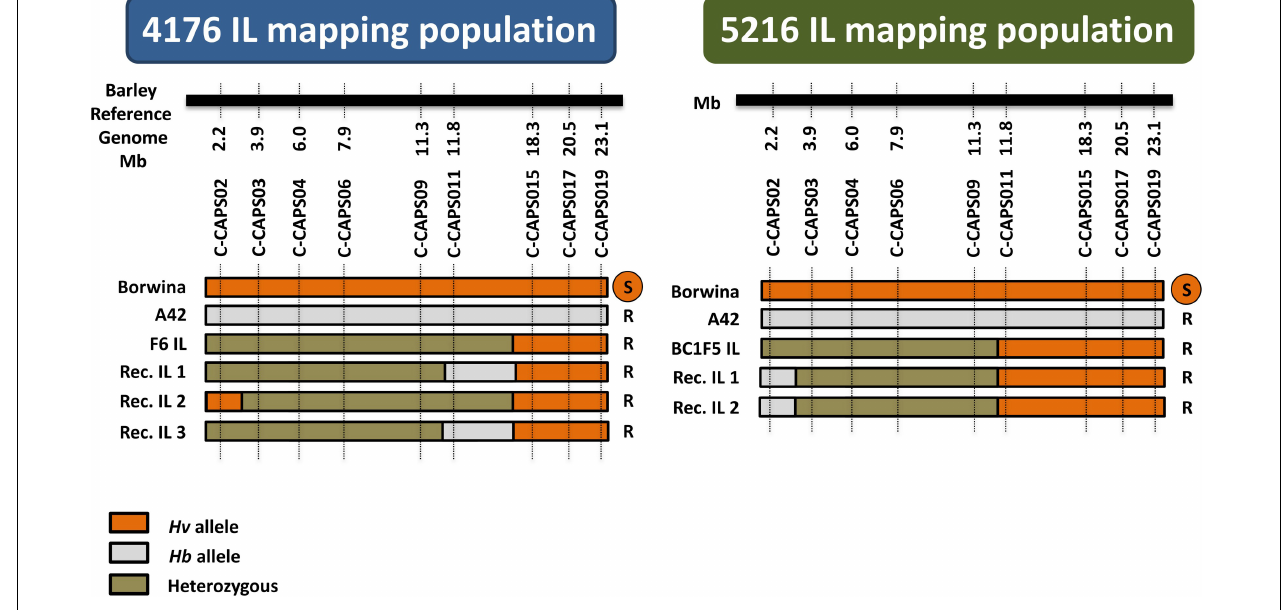
FIGURE 4 | Graphical genotypes and phenotypes of the recombinant Hv/Hb ILs from the two IL mapping populations. “Borwina” and “A42” are the original susceptible and resistant parents of the populations. “F6 IL” and “BC1F5 IL” represent the plant that was selfed in the previous generation to obtain populations “4176” and “5216,” respectively. “Rec. IL” 1 to 3 are the identified recombinant plants. Nine CAPS markers named C-CAPS02 to C-CAPS019, were developed based on conserved Hv/Hb SNP loci described in Wendler et al. (2014), spanning the terminal 23 Mbp of barley chromosome 2HS. The black horizontal bars represent schematically the barley reference genome. The physical position of each selected SNPs on the barley reference genome is written below the black line. The homozygous state of the alleles from susceptible and resistant parents is shown as orange and gray colors, respectively, whereas heterozygous state is shown in green. The phenotype of each recombinant is indicated on the right of their genotype (R = resistant; S = susceptible). The number of recombinants identified through screening with the developed markers was only three and two in IL mapping population “4176” and “5216,”